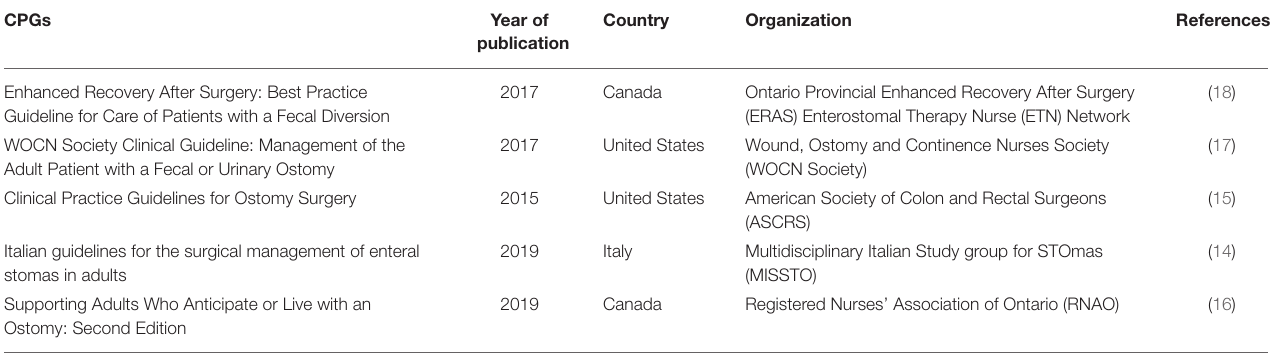
TABLE 2 | Characteristics of included CPGs.